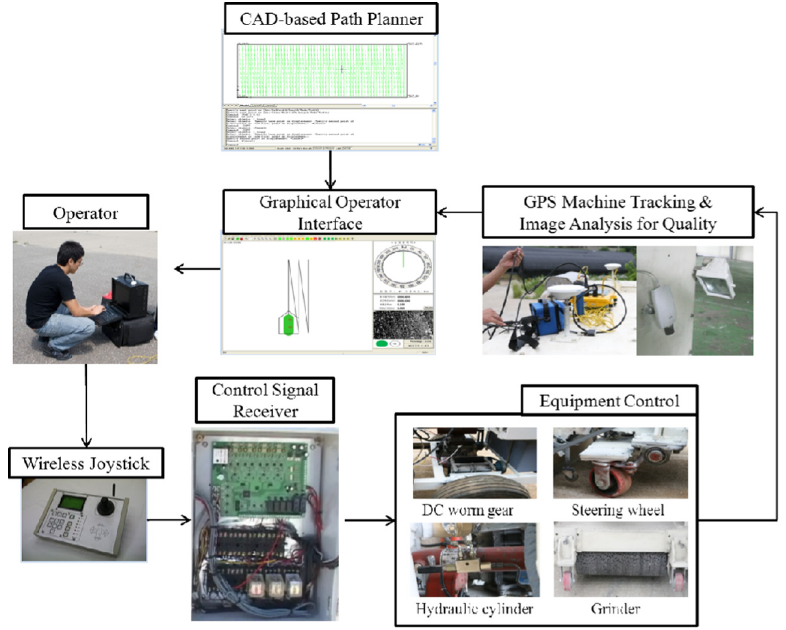
Fig. 5. Remote control system structure and